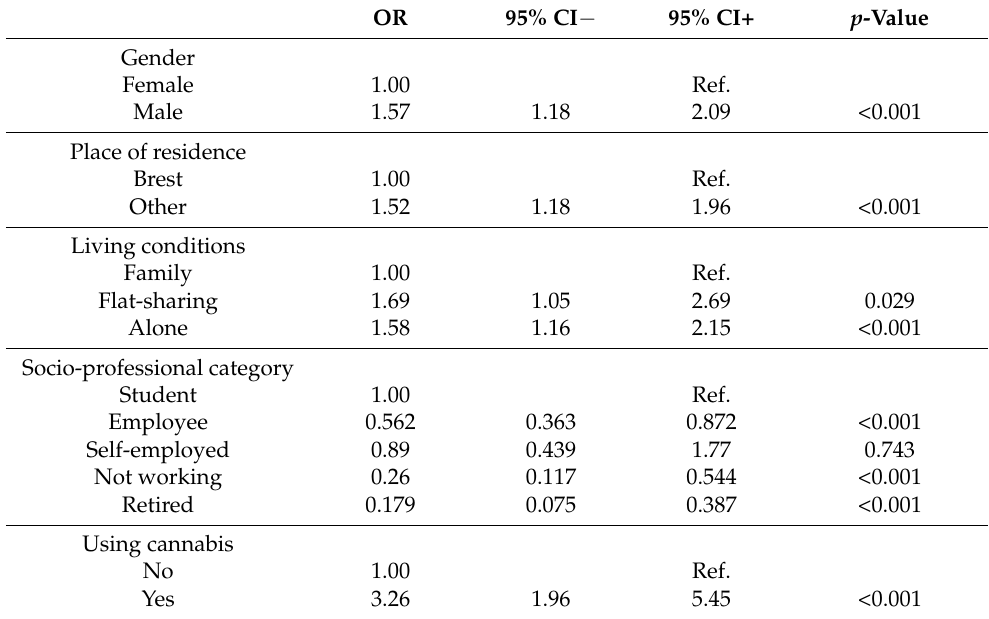
Table 3. Multivariate logistic analysis: adjusted ORs and 95% CIs for individuals who reduced or ceased alcohol consumption compared to stable alcohol consumption. OR 95% CI − 95% CI+ p -Value 1.00